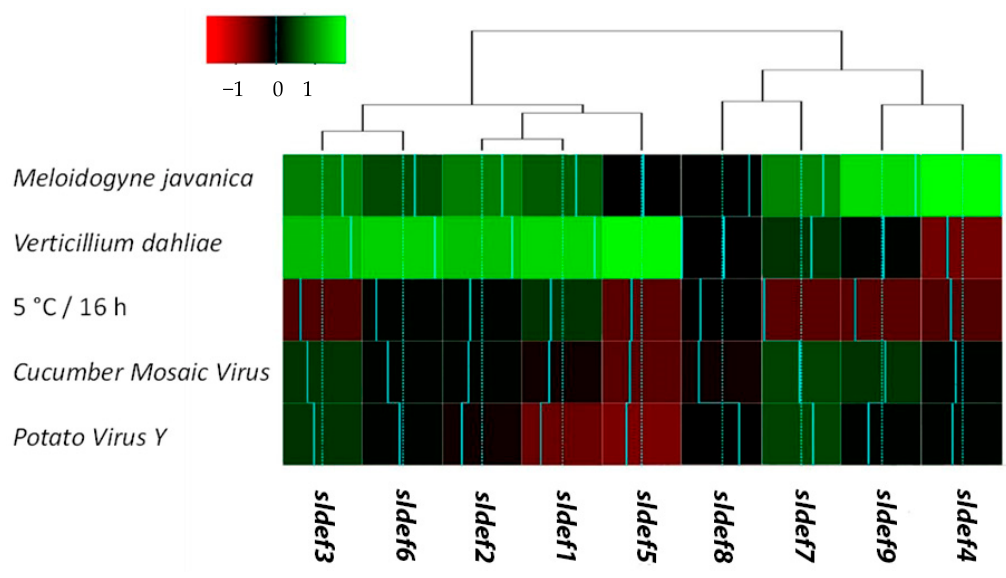
Figure 4. Heat map of relative transcription for tomato defensin genes exposed to discrete biotic / abiotic stresses. Relative mRNA abundance was assessed by real-time RT-qPCR, employing three independent biological replicates. Data were standardized across treatments. Up-regulation is delimited with green color; down-regulation is designated with red color. Two major hierarchical clusters according to stimulus–response are denoted. Statistical analysis for the treatments presented here is provided in the Supporting information 6 figure. SlDef : Solanum lycopersicum defensin. Genes sldef1 , sldef2 , sldef3 , sldef5, and sldef6 presented a somewhat comparable transcription